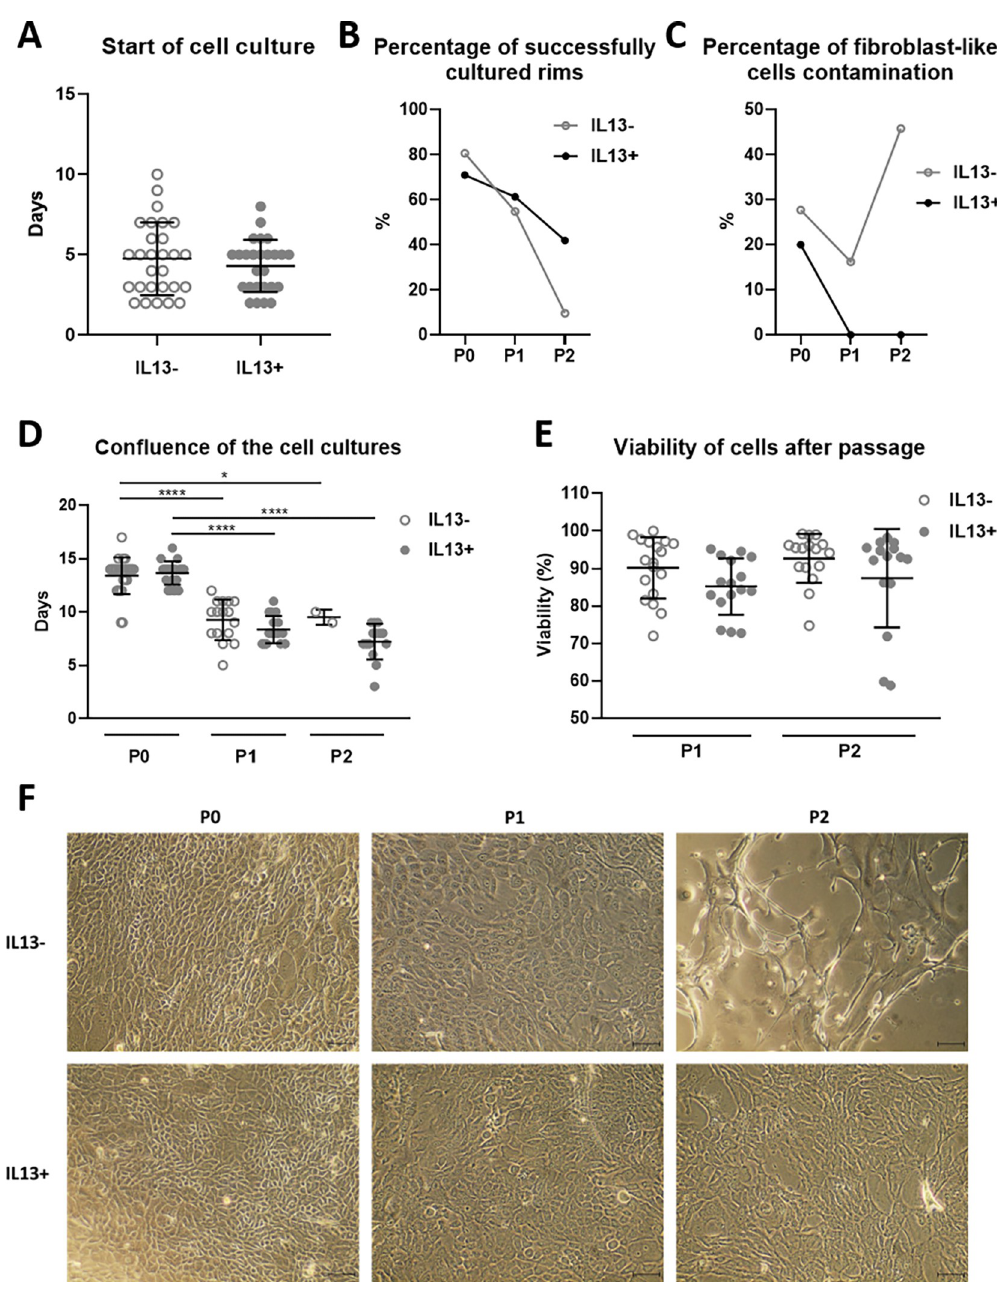
Fig 1. The growth and morphology of IL13- and IL13+ cell cultures. (A) The beginning of the outgrowth of LEC cultures from day 0 (D) to reaching full confluence in P0, P1, and P2 cultures. (B) The percentage of successfully cultured corneoscleral rims. (C) The percentage of fibroblast-like cells contamination in cell cultures. (E) Percentages of cell viability after the first and second passages. (F) Cell morphology was observed at the end of cultivation of P0, P1, and P2 cultures under an inverted phase-contrast microscope. Scale bars: 50 μ